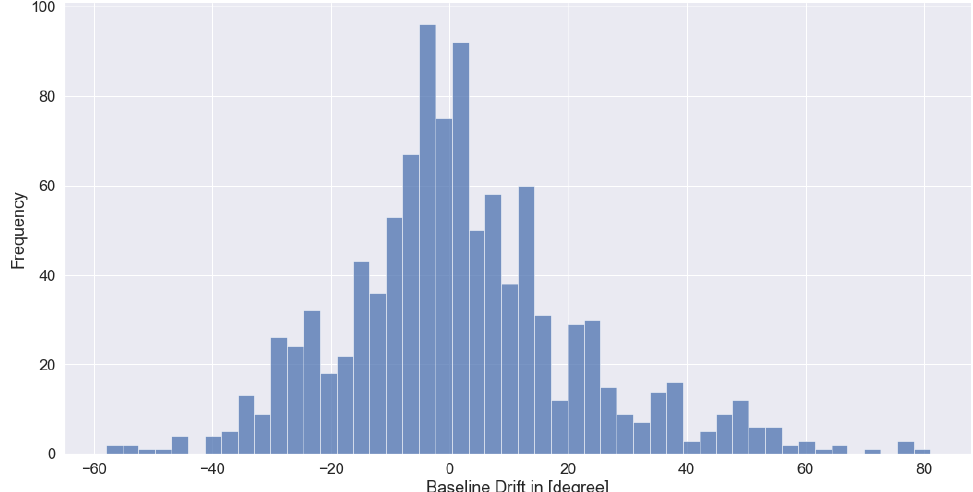
Figure 9. Results of the baseline drift analysis of the ARKit data. This is computed by minimizing the MAE by shifting the ARKit data vertically. The results show a normal distribution around 0, thus indicating no systematic baseline drift of the ARKit